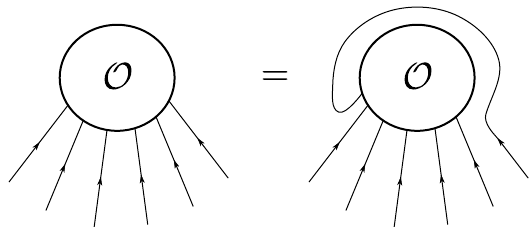
Figure 2. Graphical representation of the periodicity axiom.